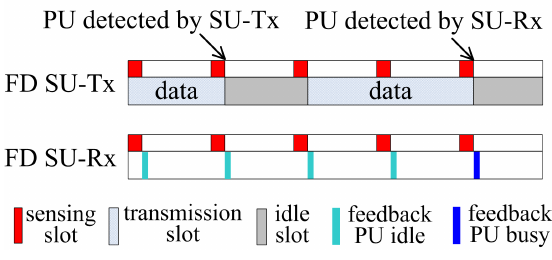
Figure 2. Scheduling of sensing, feedback and transmission in